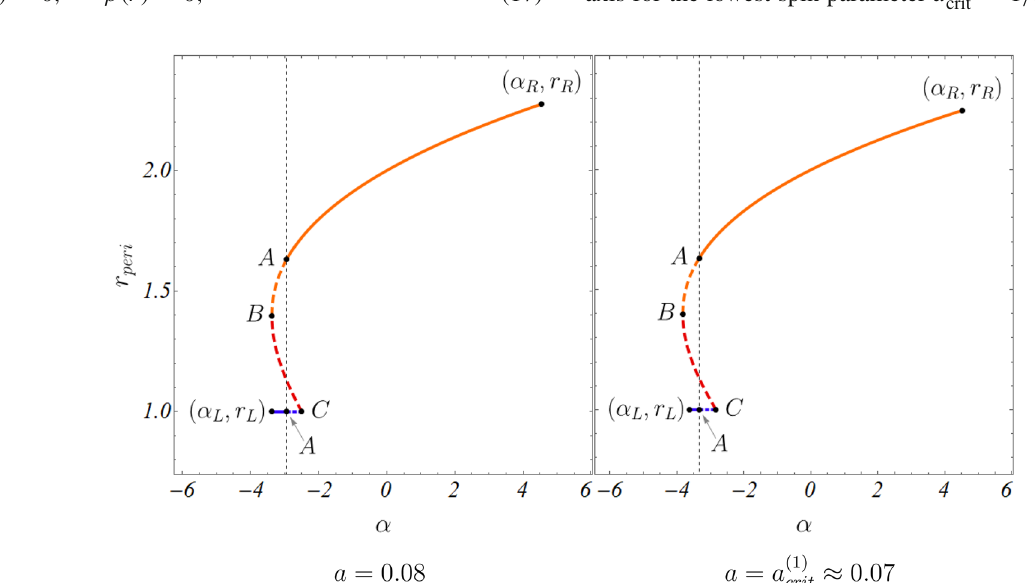
Fig. 7 Dependence of the impact parameter α on the radial distance along the shadow boundary for spin parameter a ≥ a observer’s inclination angle is θ 0 = 90 ◦ . The impact parameters of the left- and rightmost shadow edges are denoted by α L and α R , respec- tively, while the intersection point between the two shadow boundary